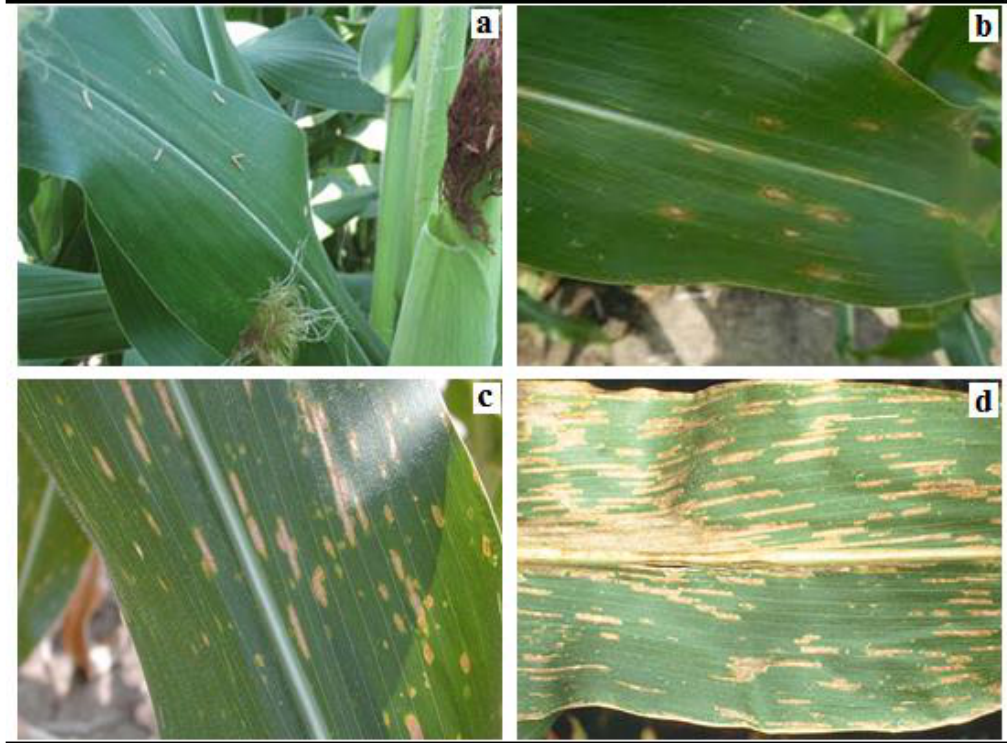
Figure 2: Maize leaves that are (a) healthy, (b, c) intermediately and (d) severely infected by Grey Leaf Spot